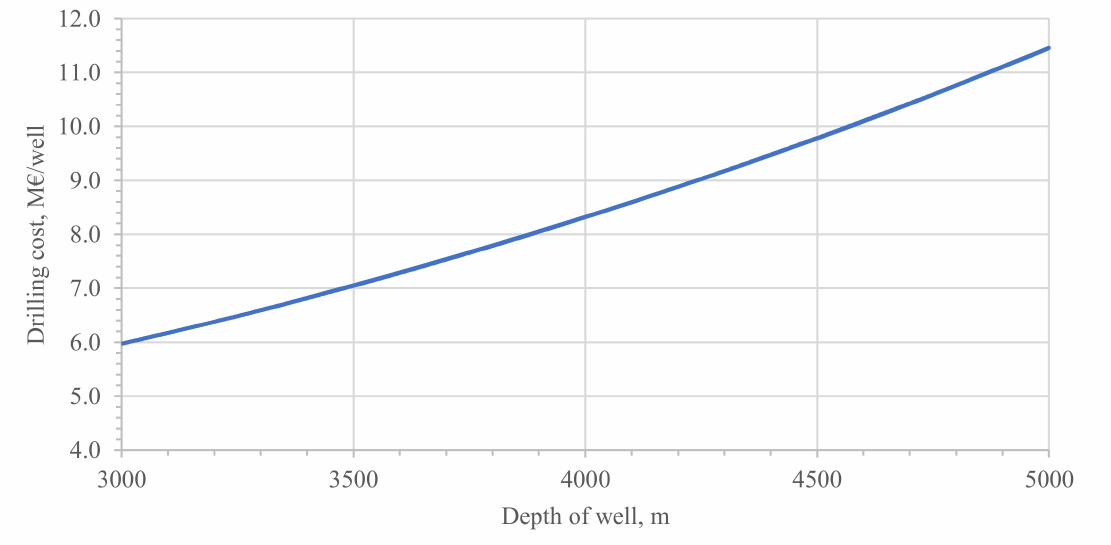
Figure 1. Cost of drilling assumed for the